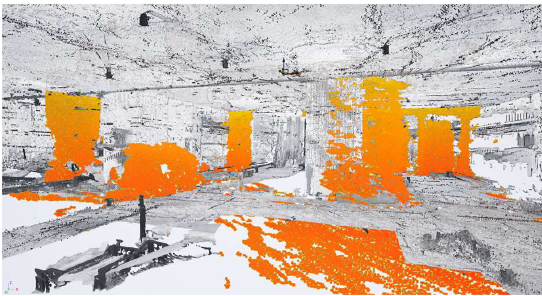
Figure 14 . Virtual visualisation of the point clouds within Unreal Engine 4. Orange gradient: SfM; Greyscale: